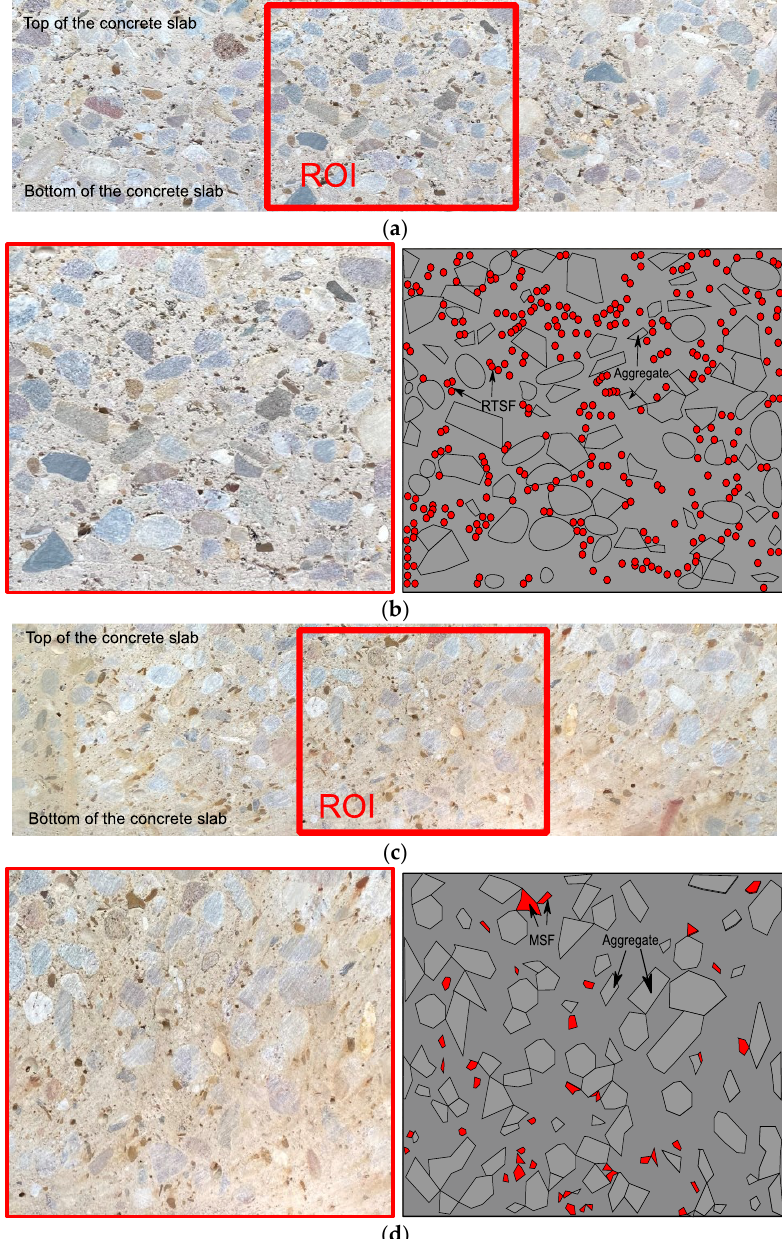
Figure 21. ( a ) Cross-section of specimen RTSFC30 and selected region of interest (ROI). ( b ). Magnified ROI of cross-section of specimen RTSFC30 ( left ) and distribution of aggregates and fibres ( right ). ( c ). Cross-section of specimen MSFC30 and selected region of interest (ROI). ( d ). Magnified ROI of cross-section of specimen MSFC30 ( left ) and distribution of aggregates and fibres ( right ).